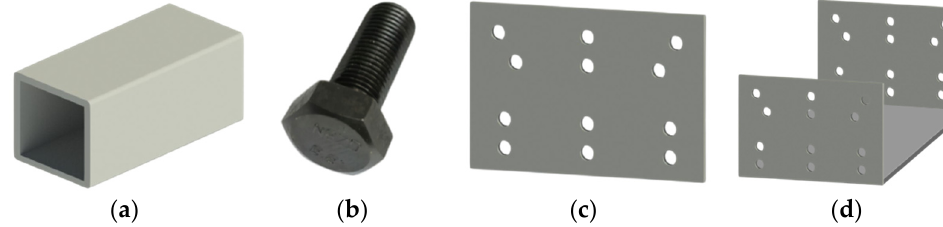
Figure 1. Materials used in tests of this study: ( a ) pultruded GFRP profiles, ( b ) steel bolt, ( c ) gusset plate, and ( d ) proposed integrated gusset plate.